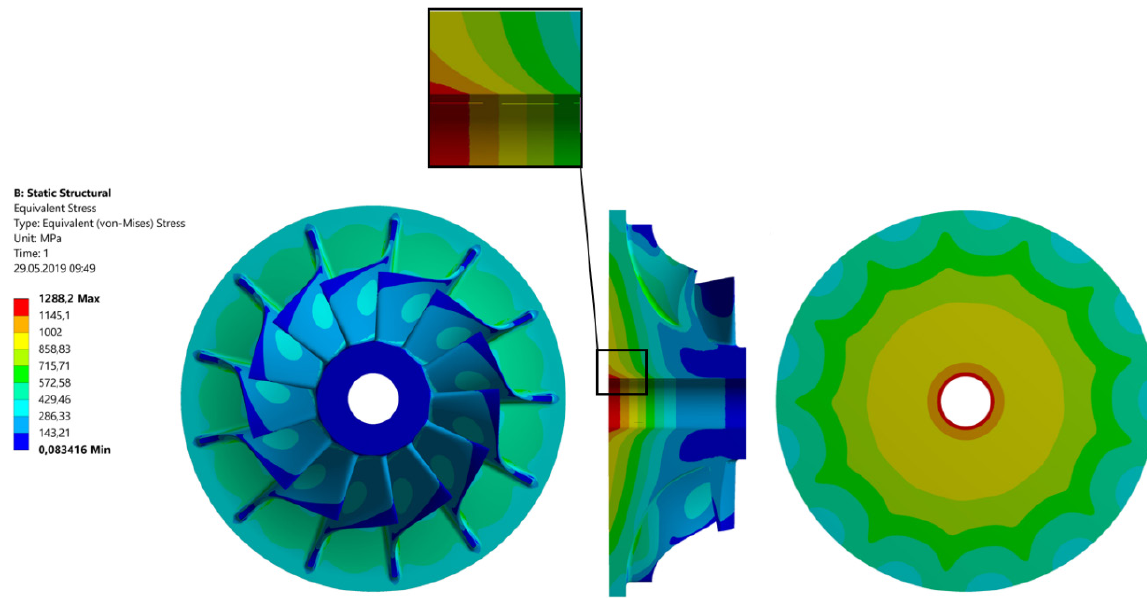
Figure 14: Equivalent von Mises stress of base turbine disc (rotational speed 96,000 rpm; temperature 600 ∘